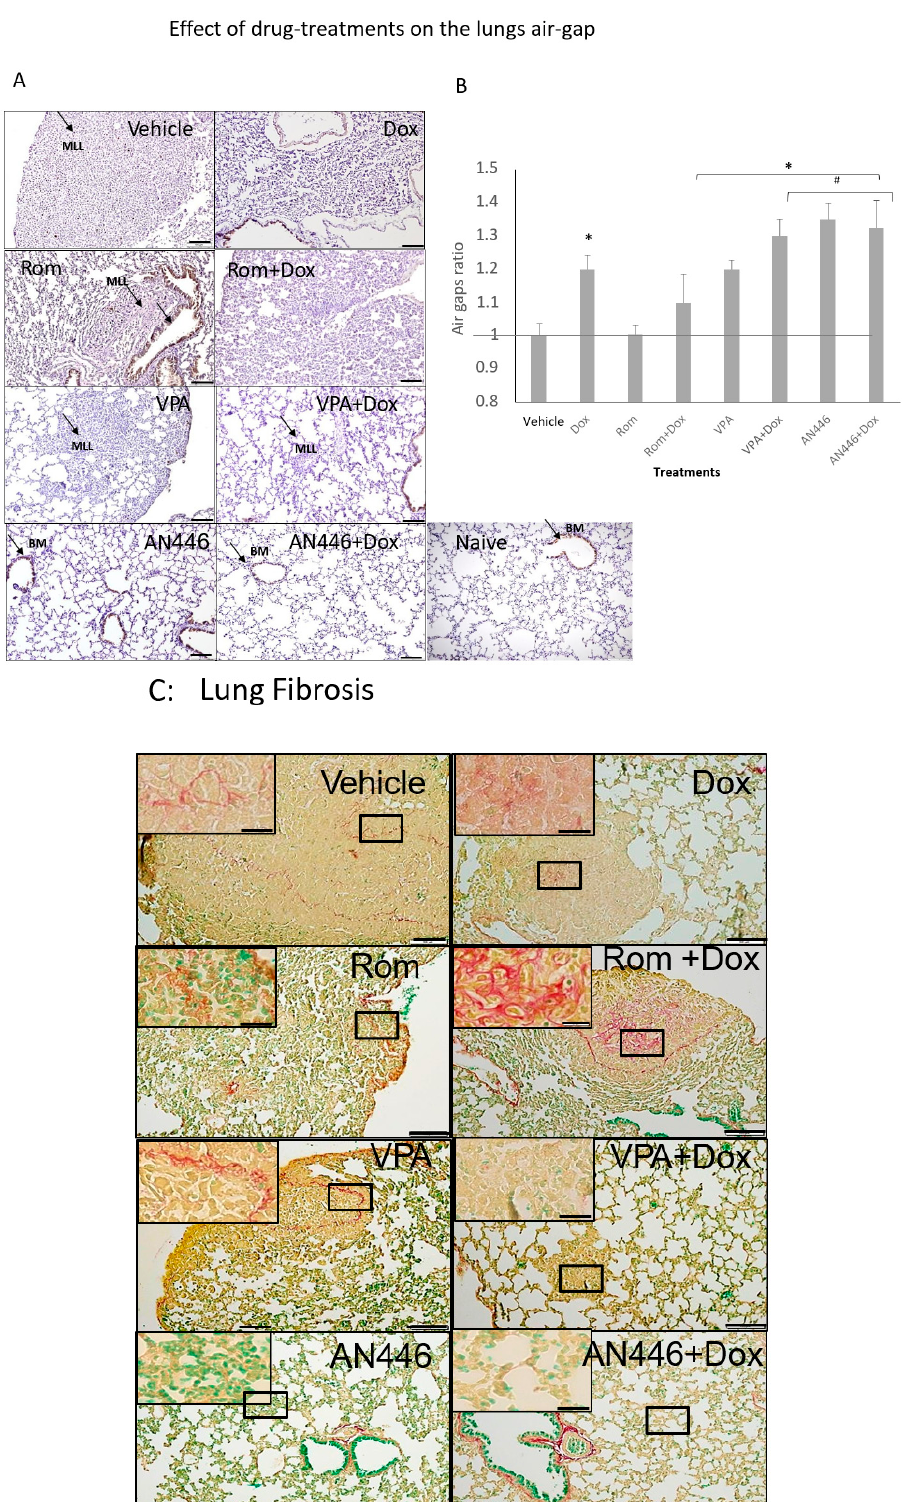
Figure 4. Effect of HDACIs, Dox, and their combinations on air space in the lungs. Sections of lungs ( A ) were stained (DAB) for Ki ‐ 67 and counterstained with H&E. Bar = 200 μ m ( B ). BM = basal membrane; MLL = metastatic lung lesions. Image analysis was conducted by ImageJ. The air gaps were evaluated as described above and plotted as a ratio of treat ‐ ment to vehicle ( B ). Adjusted p was applied with Dunn ʹ s test for multiple compression correction. The results represent the average ± SEM of 12 different fields, * p < 0.05 all drugs treated vs. vehicle ‐ treated mice; # p < 0.05 drug ‐ treated vs. Dox ‐ treated. Lung fibrosis, Sections of the lungs were stained with Picrosirius red and fast green ( C ). In hearts and tumors of the treated mice, we compared the expression levels of key proteins known to be involved in cell proliferation, regeneration, antioxidative and anti ‐ inflammatory activities, and DNA damage and repair, using Western blot analysis.